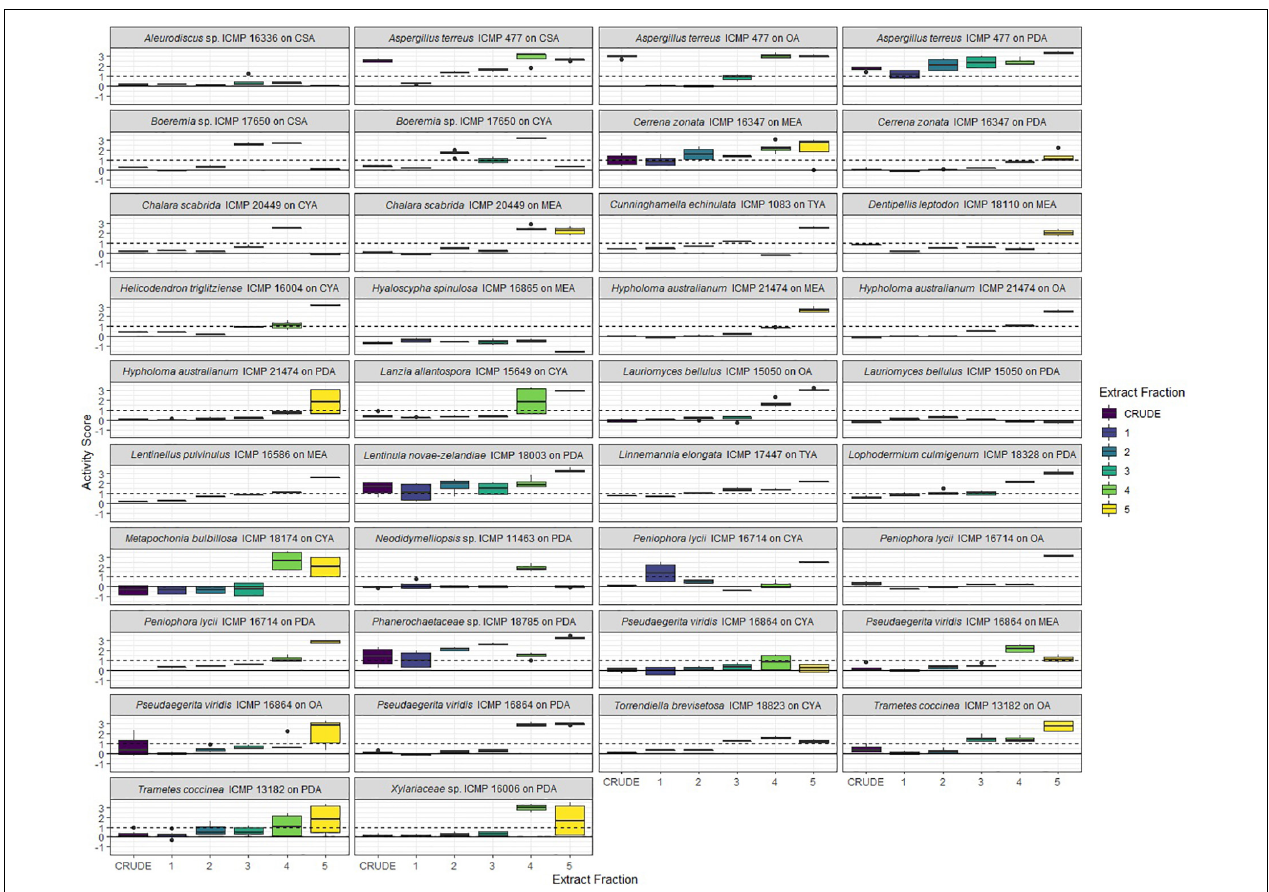
FIGURE 7 | Antibacterial activity of crude extracts and fractions 1–5 from ICMP fungal isolates against Mycobacterium abscessus BSG301. Data is presented as box and whisker plots of activity scores. The solid line shown at 0 is the median control value while the dotted line at 1 is the activity threshold. Scores above 1 correspond to a > 90% reduction in bacterial bioluminescence compared to the corresponding no-fungi control. Similarly, an activity score above 2 means corresponds to a > 99% reduction. CSA, Czapek Solution Agar; CYA, Czapek Yeast Extract Agar; MEA, Malt Extract Agar; OA, Oatmeal Agar; PDA, Potato Dextrose Agar; TYA, Tryptone Yeast Extract Agar. Boxes are upper and lower quartiles with median shown. The whiskers extend up to 1.5 × the inter-quartile range and any dots beyond those bounds are